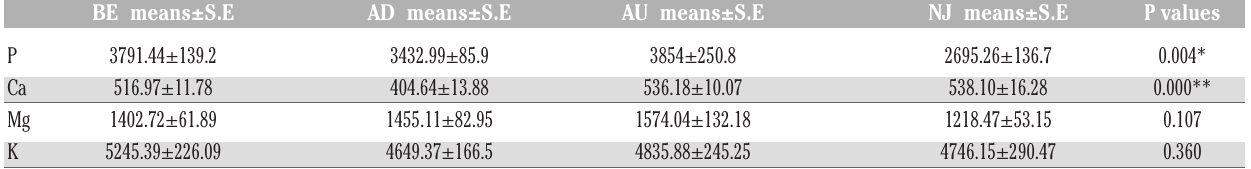
Table 3. Grain concentrations (mg/kg DW) of mineral macronutrient elements of the four wheat genotypes. BE